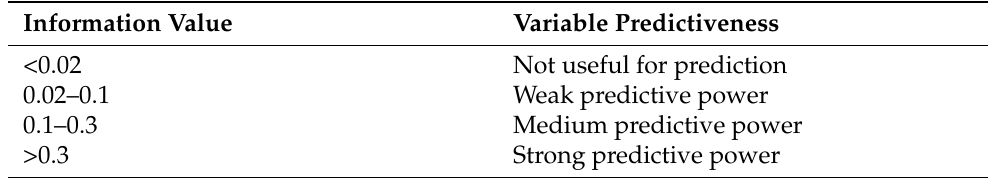
Table 2. Information Value statistic rules in credit scoring